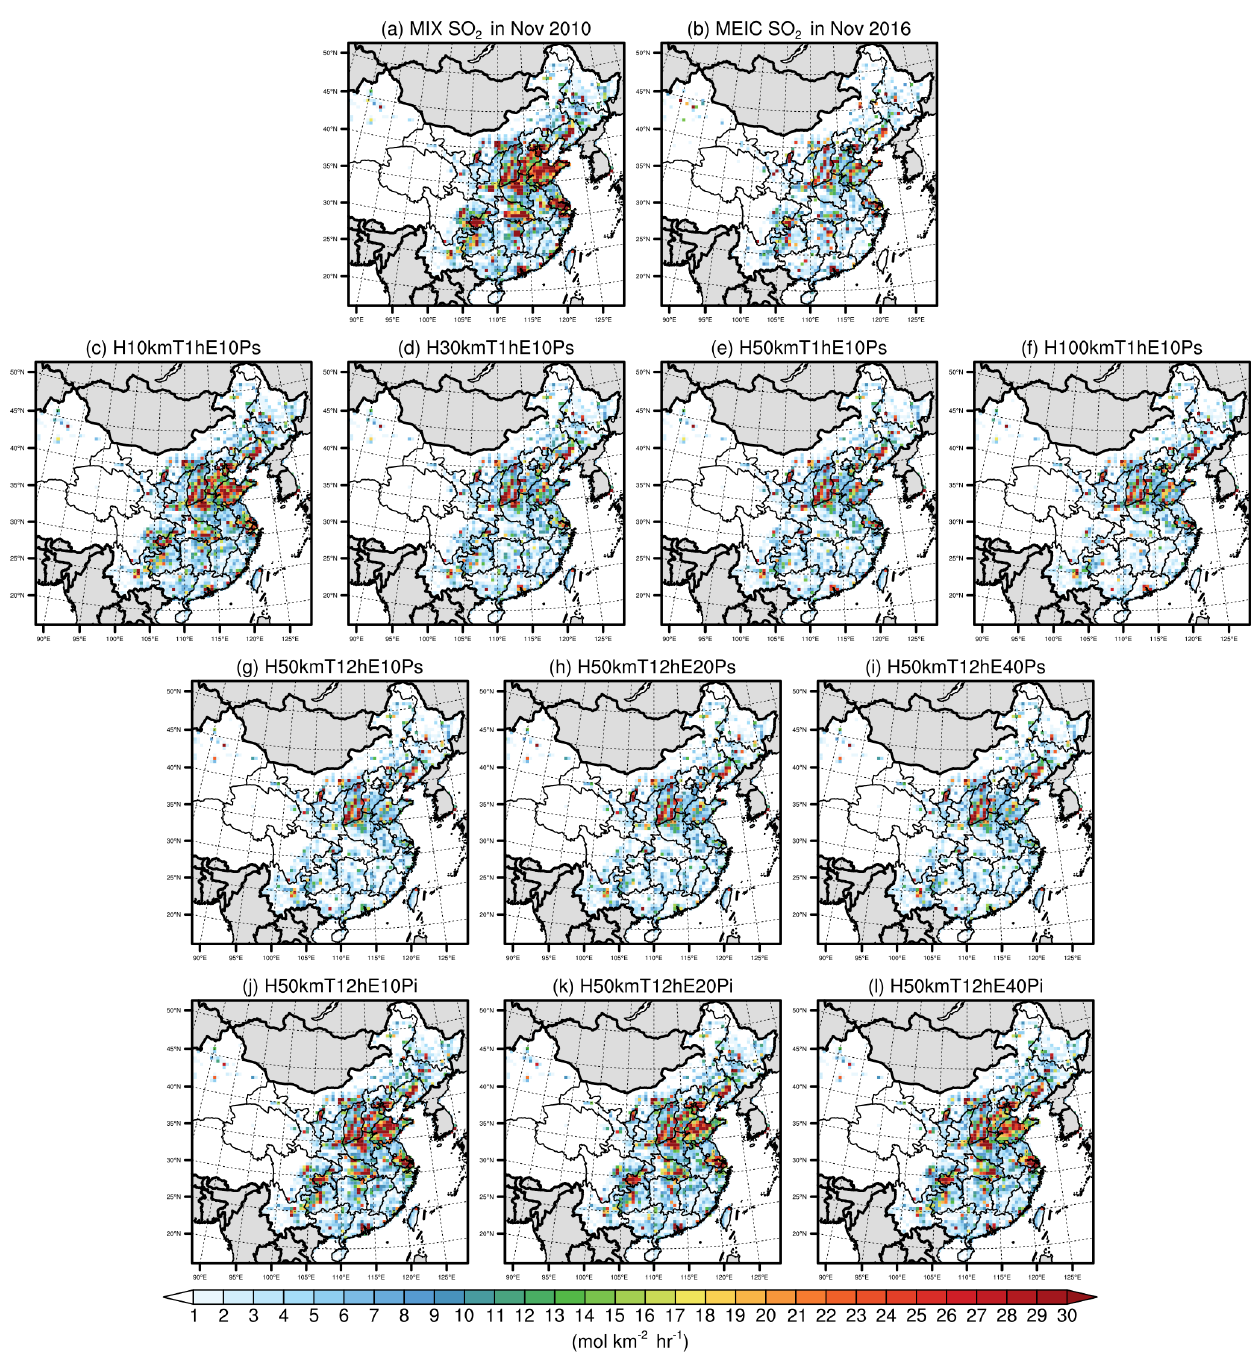
Figure 3. Spatial distributions of the MIX SO 2 emission in November 2010 (a) and the MEIC SO 2 emission in November 2016 (b) in the model’s lowest layer. Spatial distributions of the inverted SO 2 emissions in November 2016 in various data assimilation experiments (c–l)